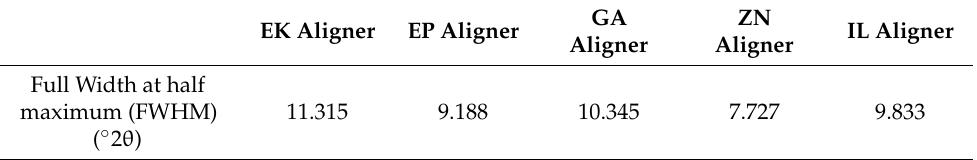
Table 3. FWHM (full width at half maximum) values of the clear aligners.